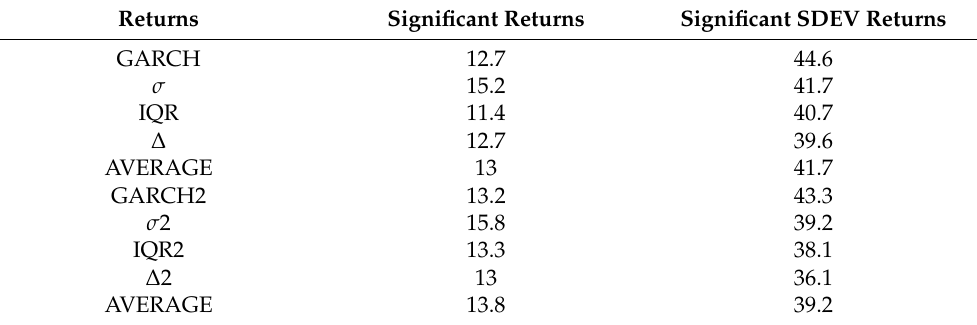
Table 2. Overview of significance and coefficient of the impact on (standard deviation of) stock returns per uncertainty